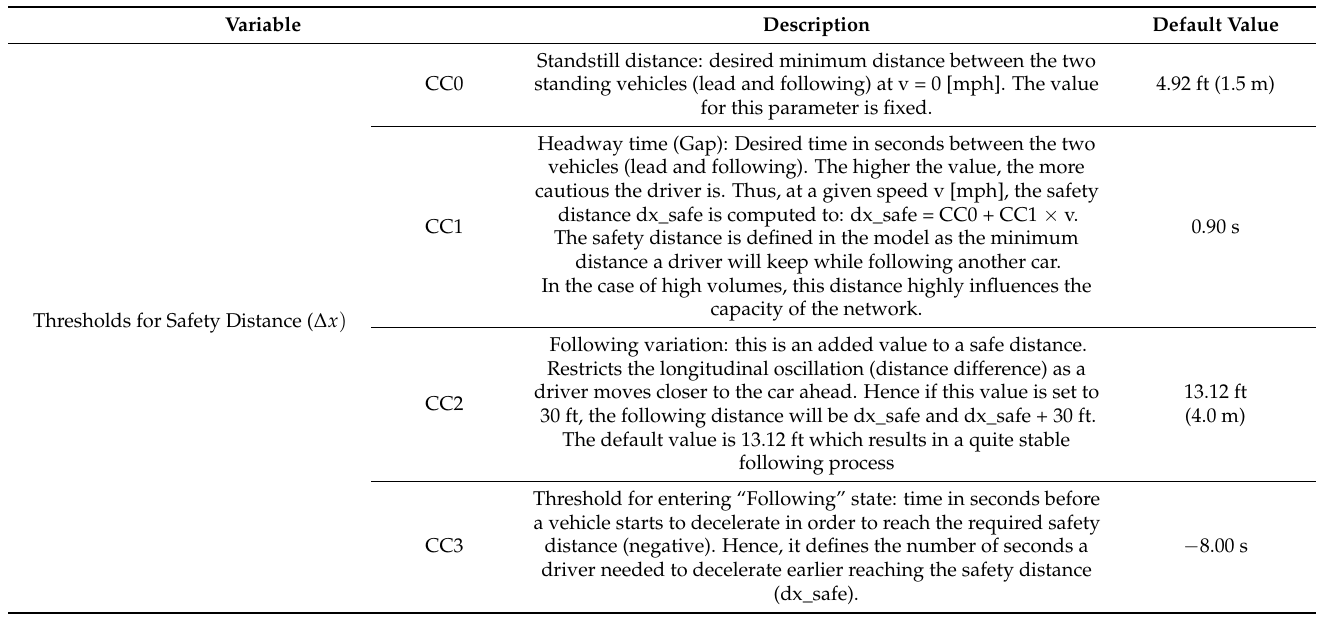
Table 5. VISSIM Wiedemann 99 car-following parameters [11].